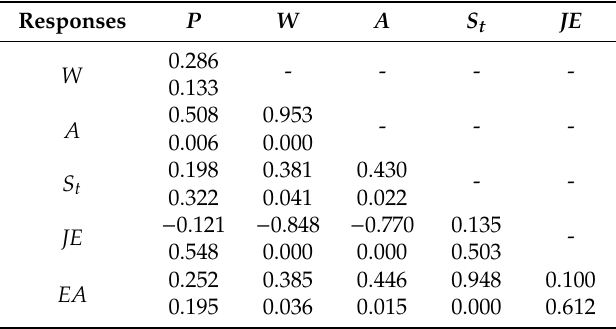
Table 14. Correlation structure among the responses.